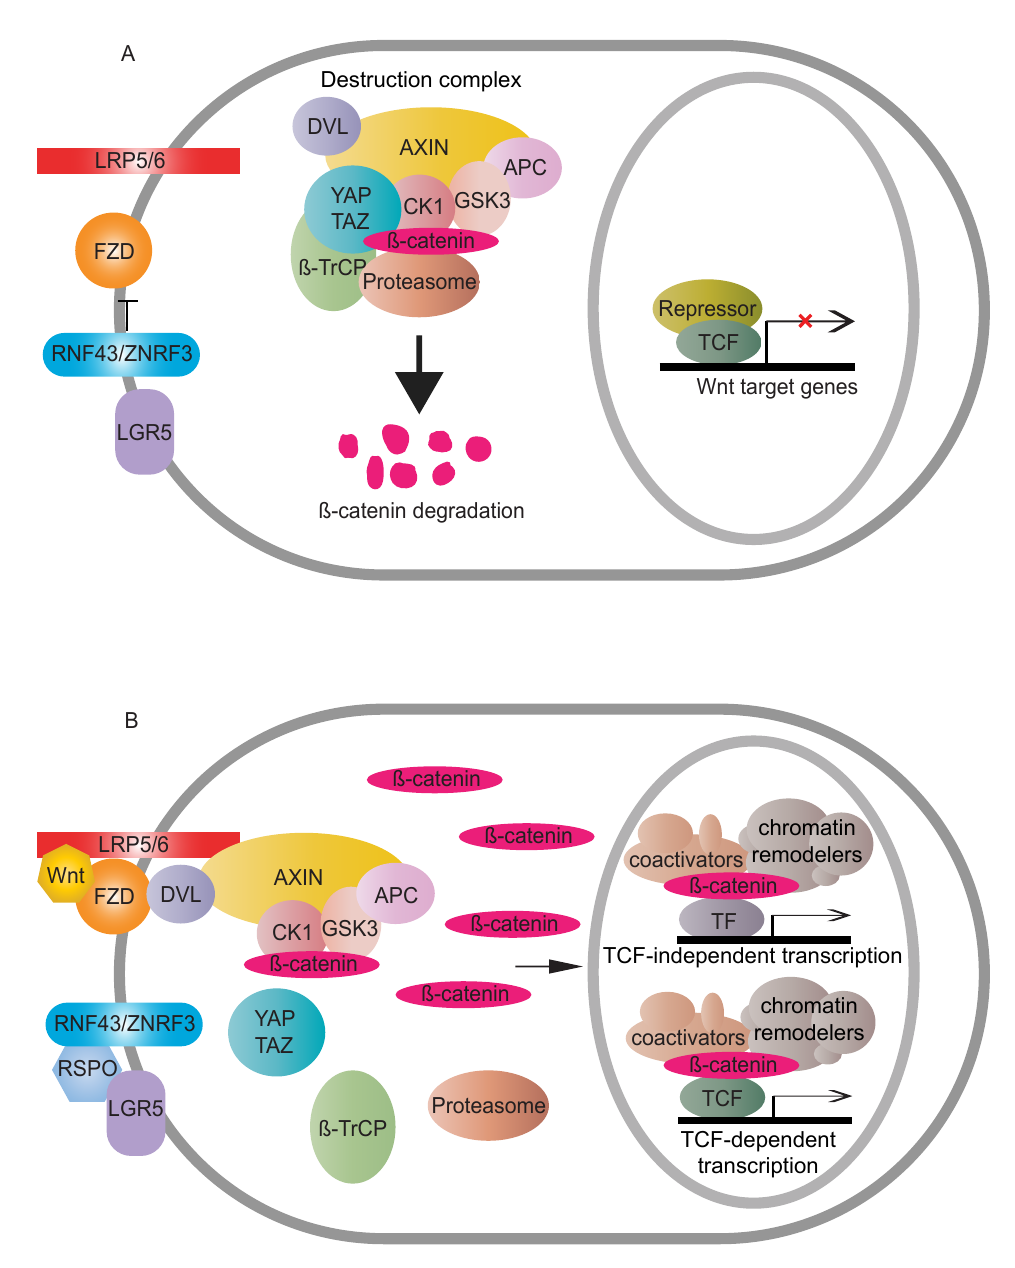
Figure 1. Overview of the Wnt canonical ( β -catenin-dependent) pathway. ( A ) In the absence of a Wnt signal, cytoplasmic β -catenin is degraded by the destruction complex. RNF43 / ZNRF3 targets FZD to antagonise Wnt signalling. The accumulative result is a transcriptional “o ff ” state. ( B ) Wnt binding causes dimerisation of FZD and LRP5 / 6. The receptor complex recruits the destruction complex to the cell membrane, and DVL assists the interactions between LRP5 / 6 and AXIN. Cytoplasmic β -catenin, thus, can be relieved from proteasome-dependent degradation. Stable β -catenin accumulates in the cytoplasm, followed by nuclear transport. There, β -catenin displaces repressive complexes and forms active complexes through associations with transcription factors and recruitment of coactivators and chromatin remodelers to upregulate Wnt responsive targets. RNF43 / ZNRF3 (cid:48) s inhibition on the Wnt pathway can be counteracted by binding of RSPO to